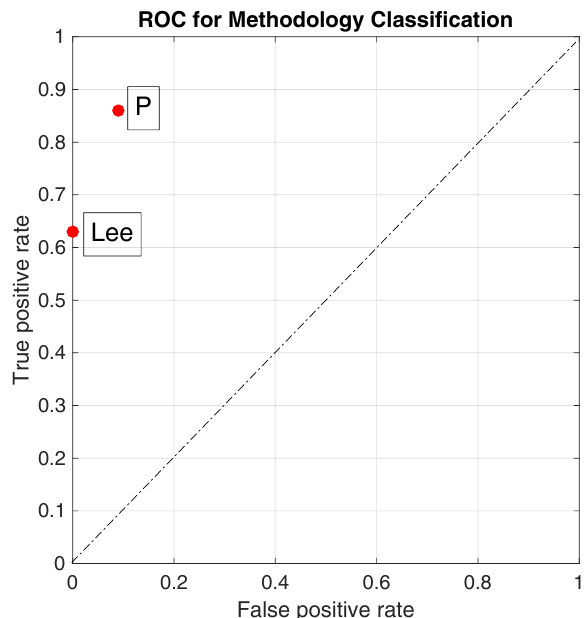
Figure 11. ROC graph showing the two approaches for binary classification. (Lee): Lee’s approach; (P): Proposed approach.